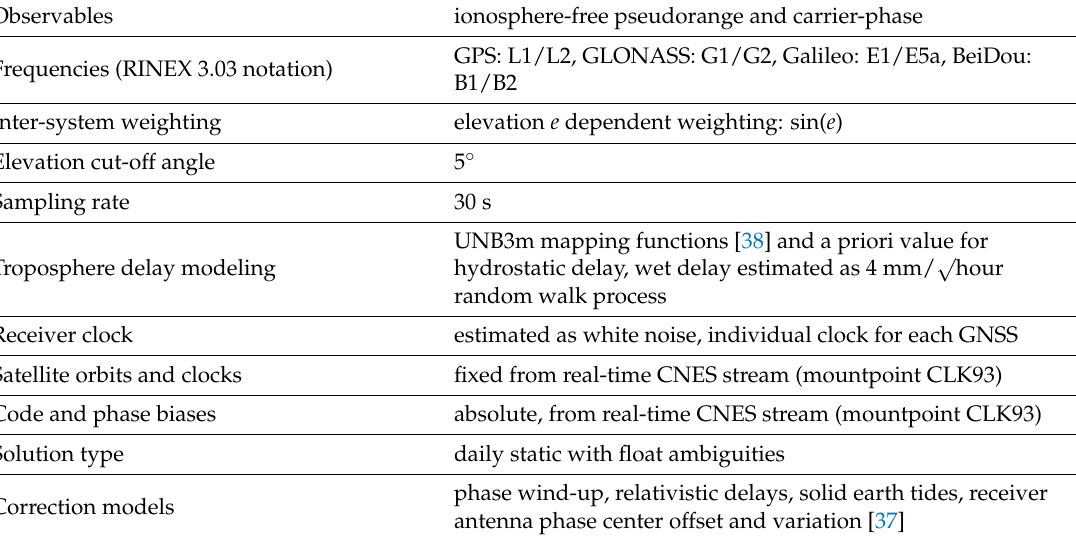
Table 2. Summary of the Precise Point Positioning (PPP) processing